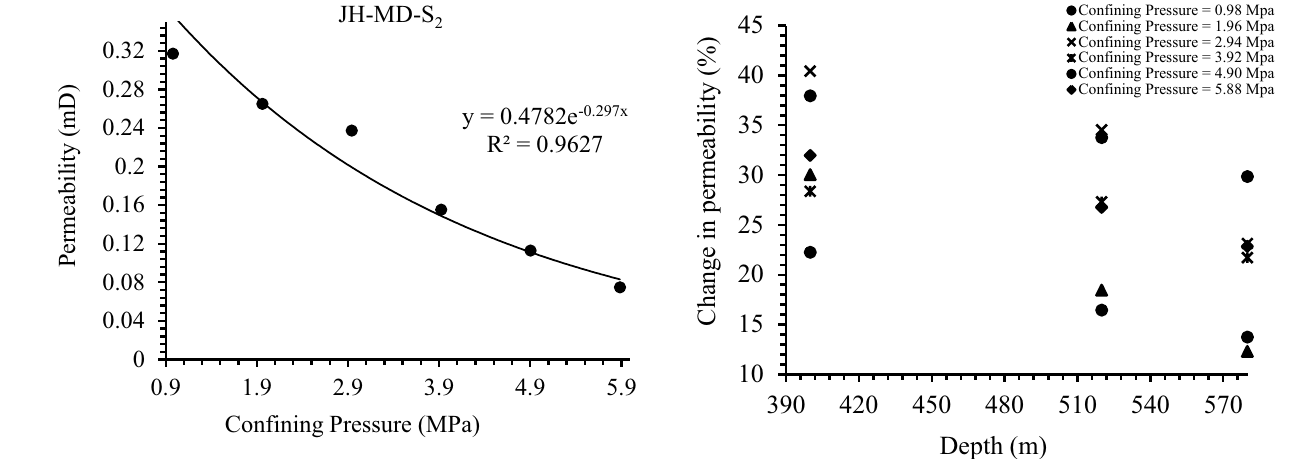
Fig. 13 Variation of permeability with depth at varying